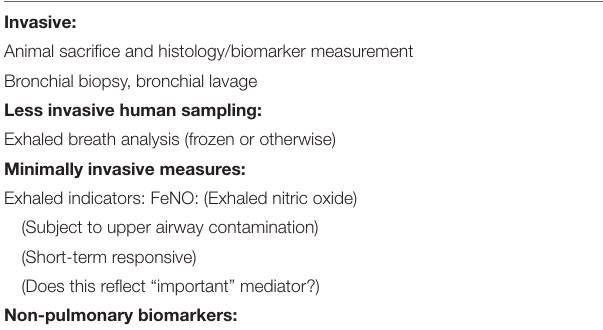
TABLE 1 | Markers of pulmonary inflammation